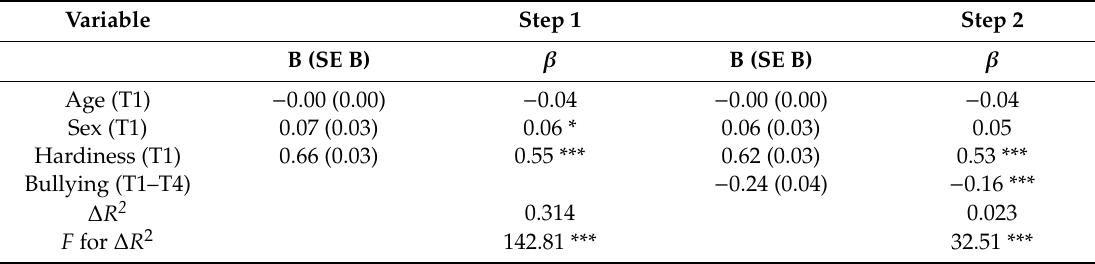
Table 2. Hierarchical multiple regression analysis of exposure to bullying behaviors from T1 to T4 predicting psychological hardiness at T5, controlled for age, sex, and psychological hardiness measured at T1. Unstandardized beta coe ffi cient (B) with standard error (SE B), and the standardized beta coe ffi cient ( β ) are